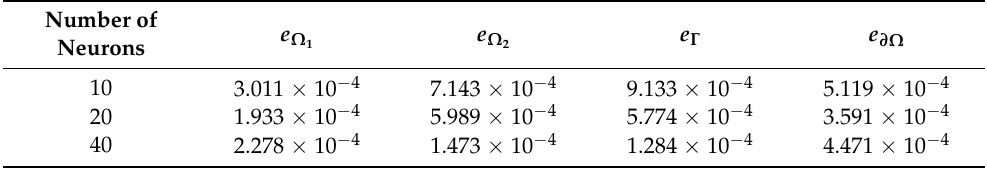
Table 8. Comparison of errors in different terms with different numbers of neurons for Example